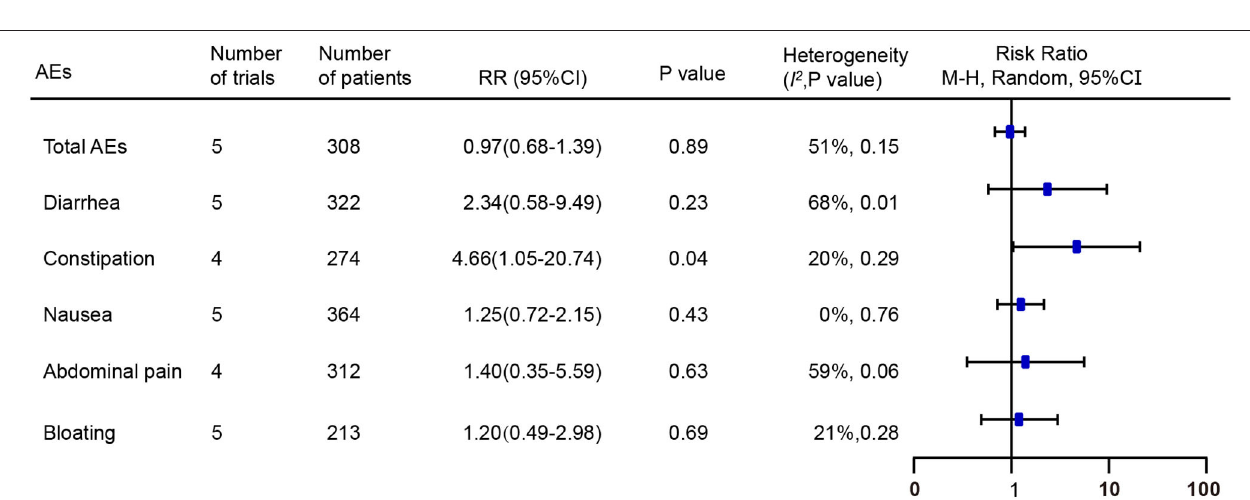
FIGURE 6 | Forest plot of the effect of FMT on total and individual adverse events compared with placebo. RR, risk ratio; 95% CI, 95% confidence